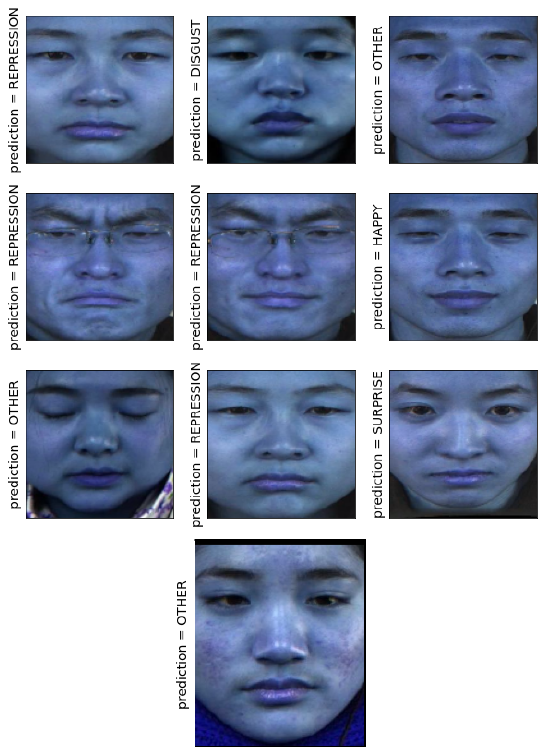
Figure 11. LARNet prediction on CASME II dataset (cropped faces).